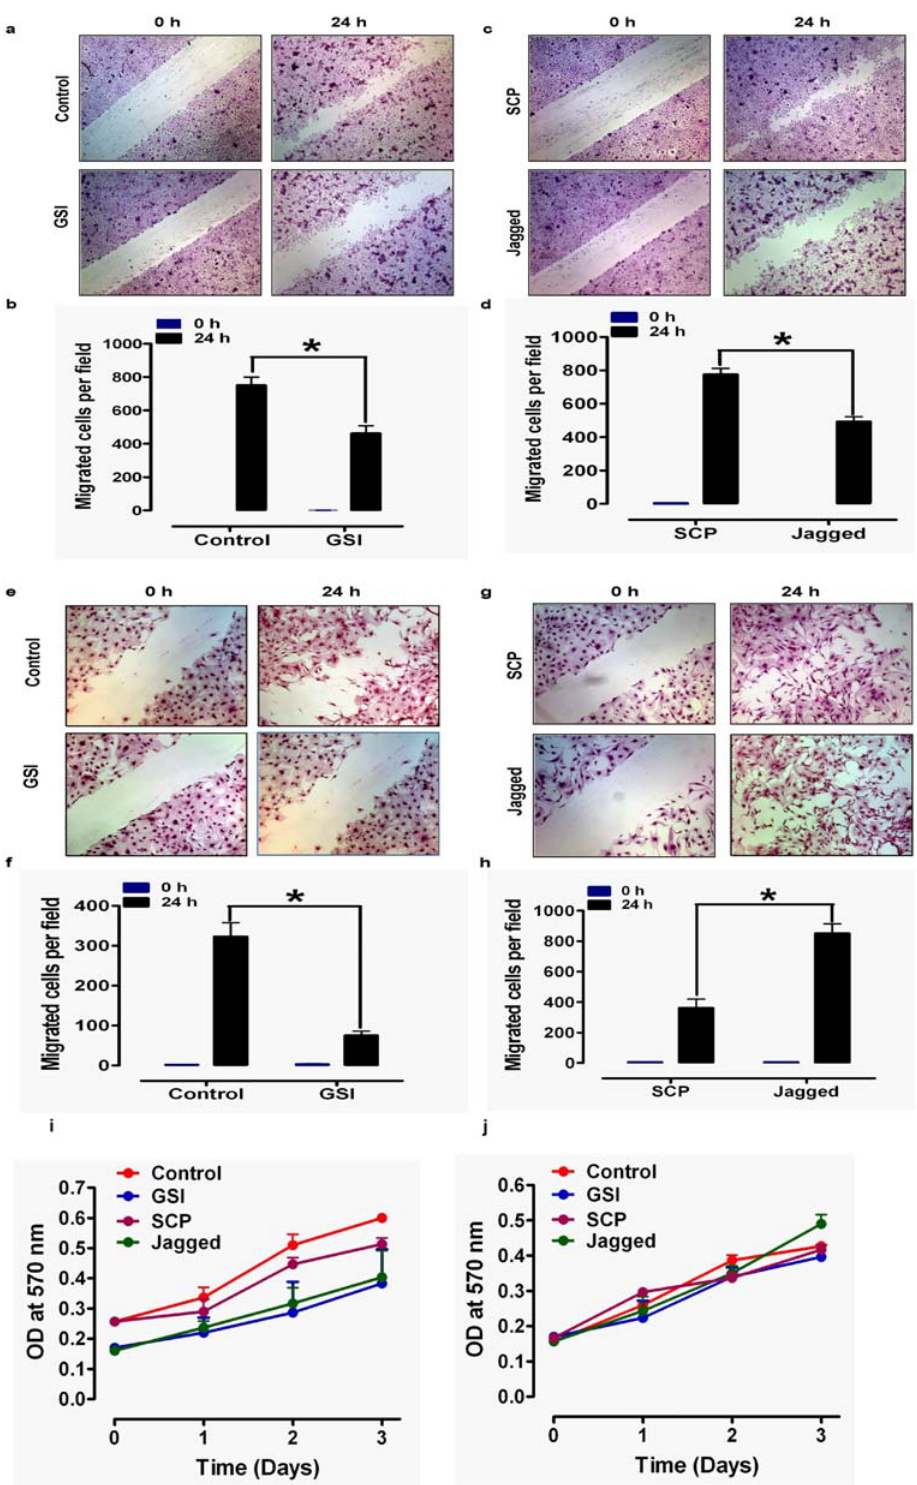
Figure 5. Evidence that Notch signaling regulates the behaviors of keratinocytes and skin fibroblasts. a–h. Monolayers of cultured keratinocytes (a–d) or fibroblasts (e–h) were treated with vehicle (Control), GSI (10 m M DAPT), 15 m M SCP or 15 m M Jagged peptide, and were then subjected to scratch wounding. Eighteen hours after wounding, images of the wound area were acquired and the number of cells per field that had migrated into the cell-free wound zone were determined for each culture. Representative images (a, c, e, g) and quantitative data (b, d, f, h) are shown. Values are the mean and SEM (n=3 separate experiments). *p , 0.001. i and j. Cultured keratinocytes (i) and fibroblasts (j) were treated with vehicle (Control), GSI (10 m M DAPT), 15 m M SCP or 15 m M Jagged peptide for the indicated time periods and relative cell numbers were estimated. Values are the mean and SEM (n=4–6 experiments).